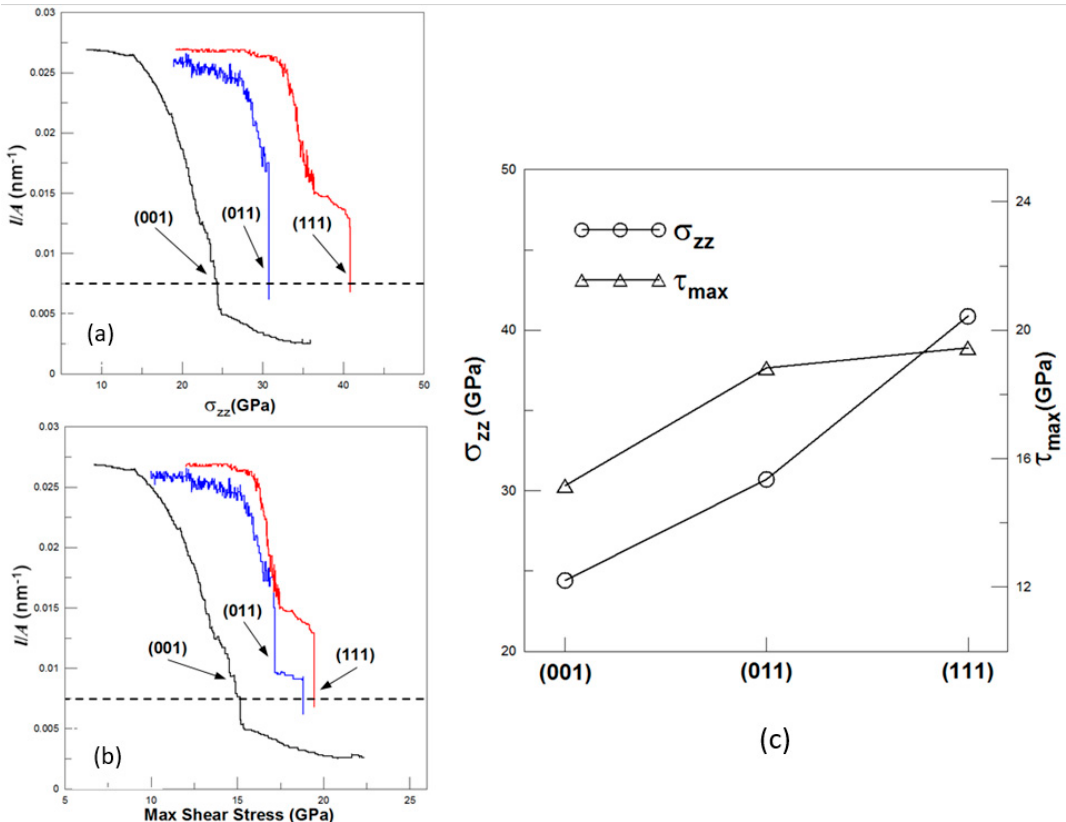
Figure 14. Relationship between stress and resistance represented by l/A ( a ) resistance vs. axial stress; ( b ) resistance vs. maximum shear stress; ( c ) comparison of stress at l/A = 0.0075 between (001), (011), and (111) orientation surfaces.